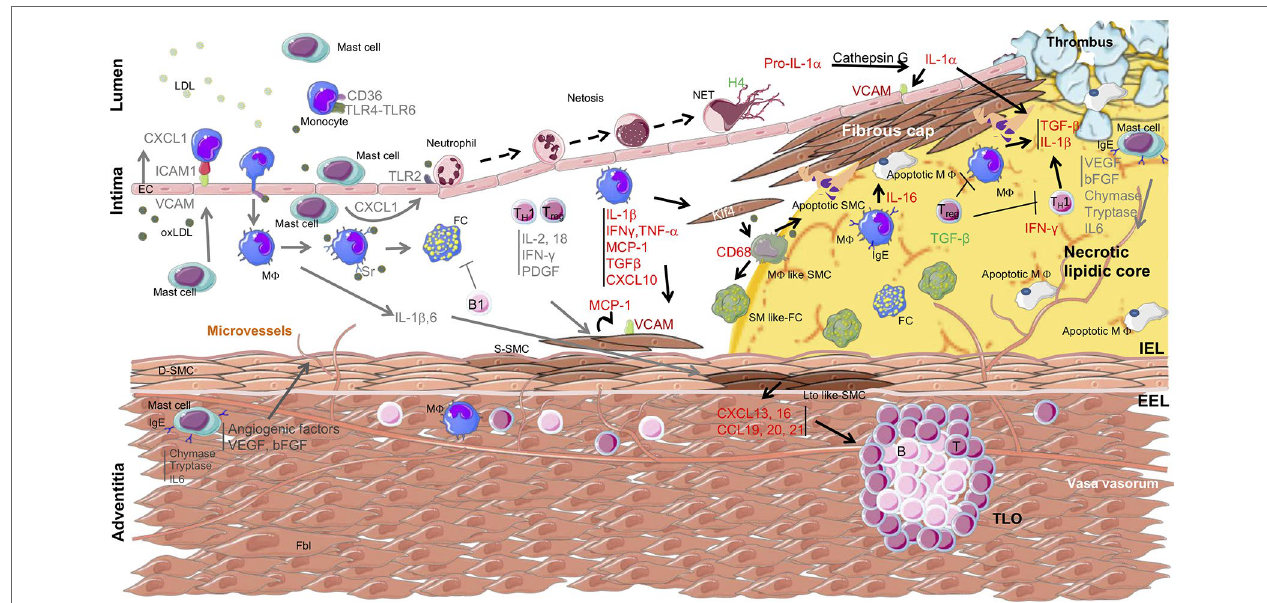
FIGURE 1 | Overview of immune cell localization, cytokine secretion, and interaction with smooth muscle cells within the arterial wall during atherosclerosis progression. Arrows indicate the origin and target of immune mediators between the different cell types involved in atherosclerosis. The yellow area indicates the necrolipidic core. D-SMC, differentiated smooth muscle cell; S-SMC, synthetic smooth muscle cell; Lto like-SMC, tissue organizer-like smooth muscle cell; SM like-FC, smooth muscle like-foam cell; MΦ like SMC, macrophage like smooth muscle cell; apoptotic SMC, apoptotic smooth muscle cell; EC, epithelial cell; Fbl, fibroblast; TLO, tertiary lymphoid organ; IEL, internal elastic lamina; EEL, external elastic lamina; TC, lymphocyte T cell; BC, lymphocyte B cell; MΦ, macrophage; FC, foam cell; apoptotic MΦ, apoptotic macrophage; LDL, low-density lipoprotein; oxLDL, oxidized low-density lipoprotein; NETs, neutrophils extracellular traps; TLR, Toll-like receptor; CD, cluster of differentiation; KLF4, Kruppel-like factor 4; IgE, immunoglobulin type E; H4, histone H4; ICAM, intercellular adhesion molecule; VCAM, vascular cell adhesion molecule; IFN, interferon; PDGF, platelet-derived growth factor; MCP1, monocyte chemokine protein 1; TGF, transforming growth factor; CXCL, C-X-C motif chemokine; CCL, chemokine Ligands.